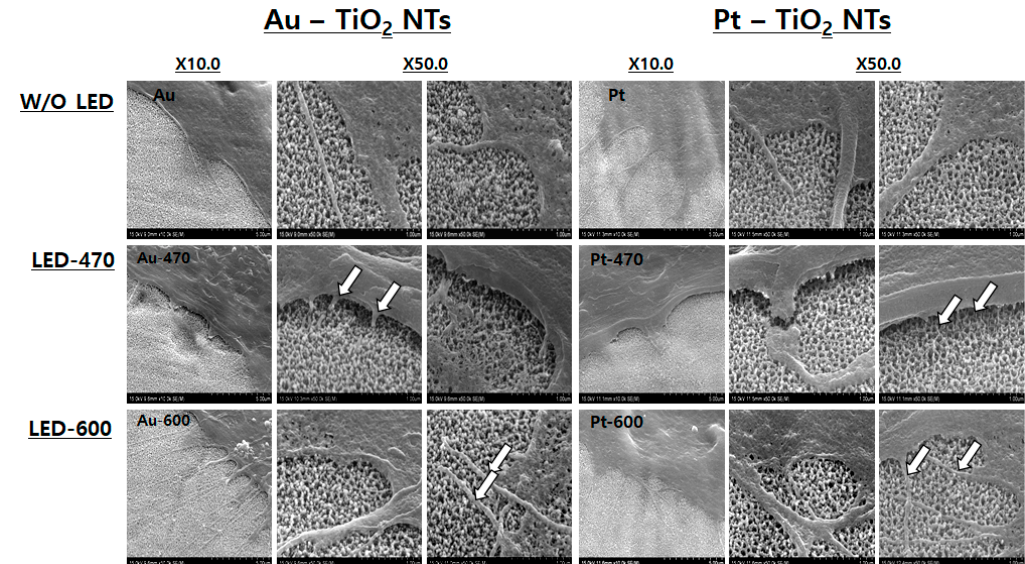
Figure 7. Filopodia images of hMSCs cultured on Au–TiO 2 NTs and Pt–TiO 2 NTs before and after 470 nm and 600 nm visible light irradiation (as observed by FE-SEM).